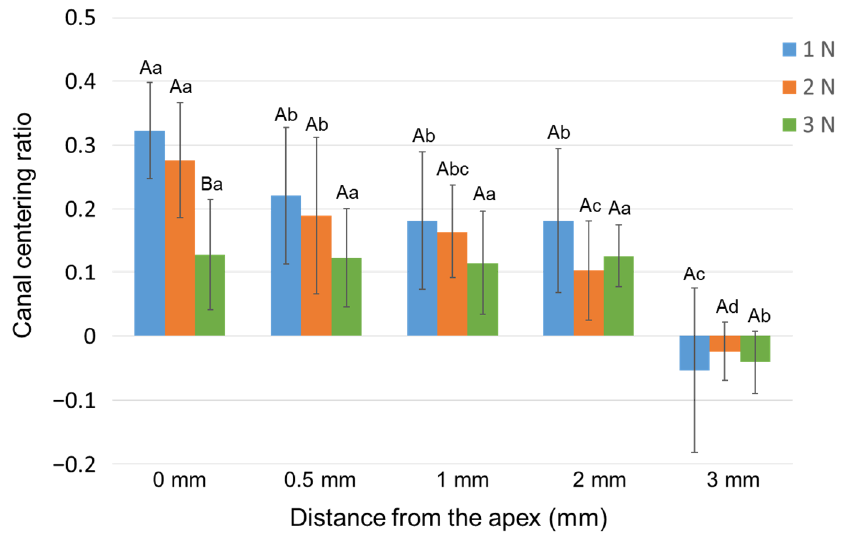
Figure 3. Effect of different downward loads on the canal centering ratio. Data are the mean and standard deviation ( n = 10 in each group). Values with different capital letters at the same distance and values with different small letters at the same downward load are significantly different ( p < 0.05).